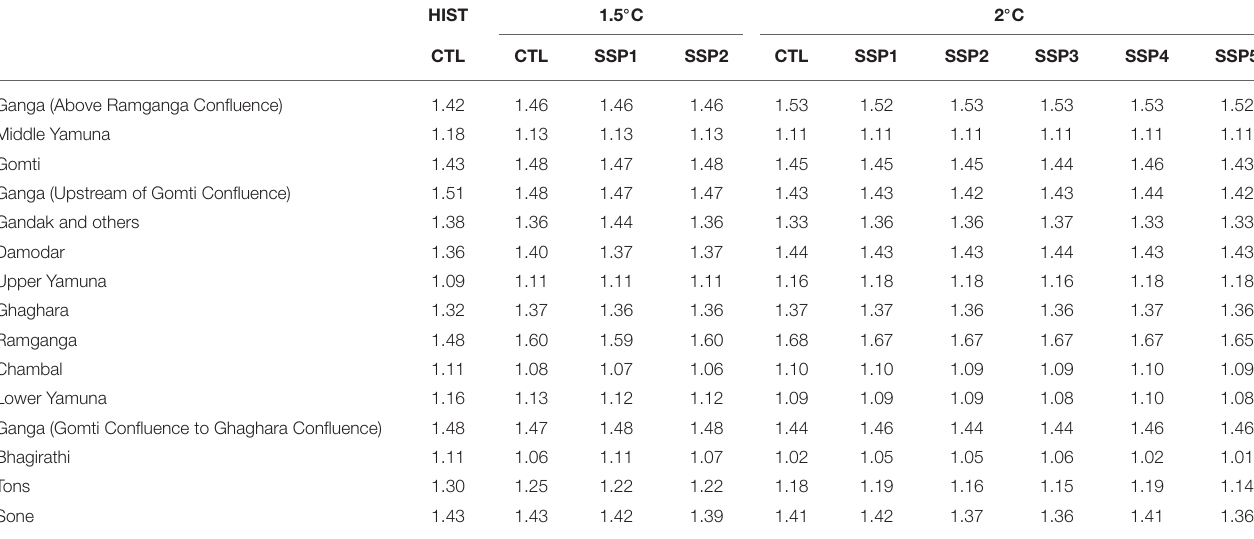
TABLE 3 | Calculated basin characteristics parameter for all sub-basins and